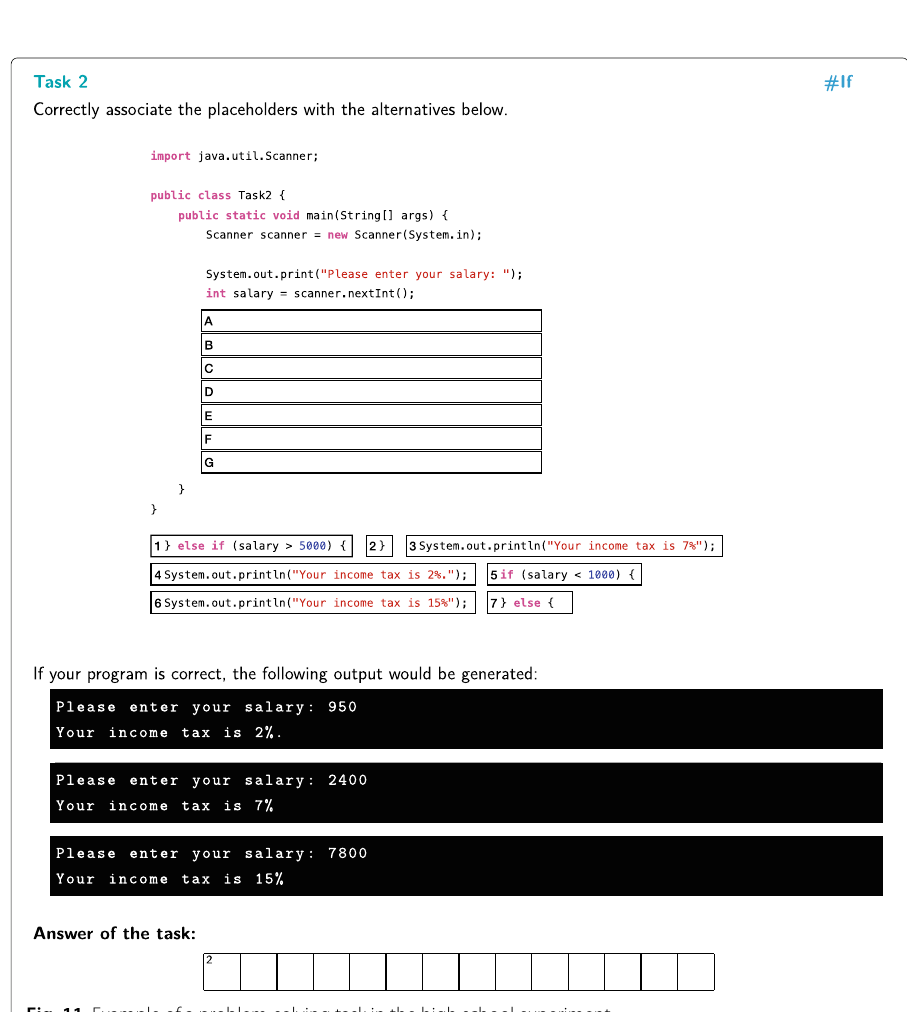
Fig. 11 Example of a problem-solving task in the high school